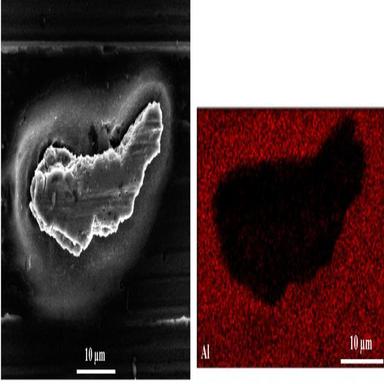
(a) Scanning electron microscope and Energy-dispersive X-ray spectroscopy mapping of: (b) Al, (c) Fe, and (d) O distribution of the impurities in Al-based alloy.